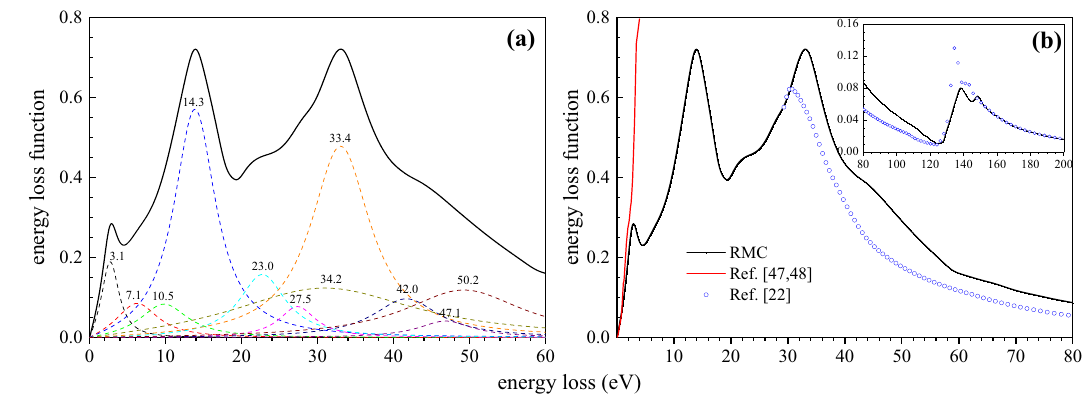
Figure 5. ( a ) A plot of ELF deduced from the experimental REELS spectrum by RMC method (solid line) together with 11 Drude terms (dashed lines); ( b ) Comparison on ELF of Sm between the present RMC result (black), Ref. 22 (blue circles) and Ref. 47,48 (red line).